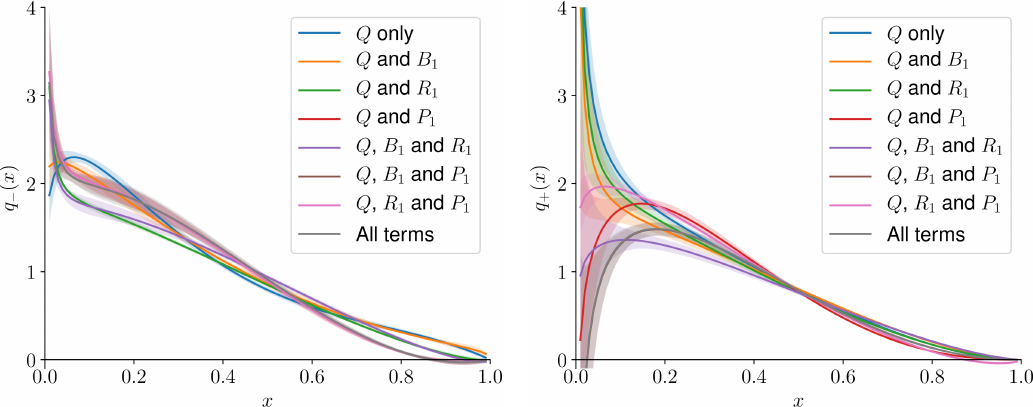
Figure 7 . The results of fitting with various nuisance terms included.